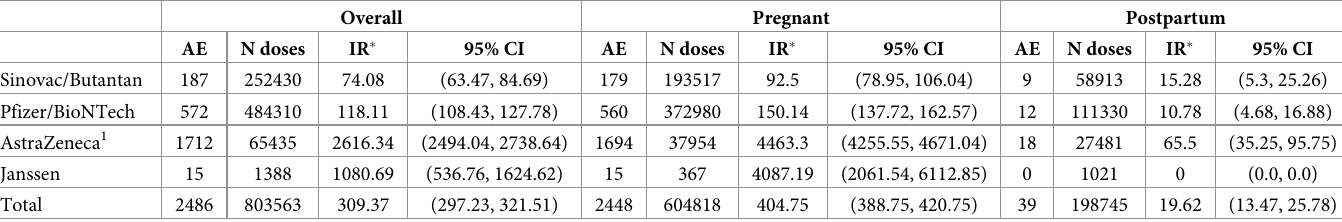
Table 2. Incidence of adverse events notified by Brazilian pregnant and postpartum women by vaccine received.